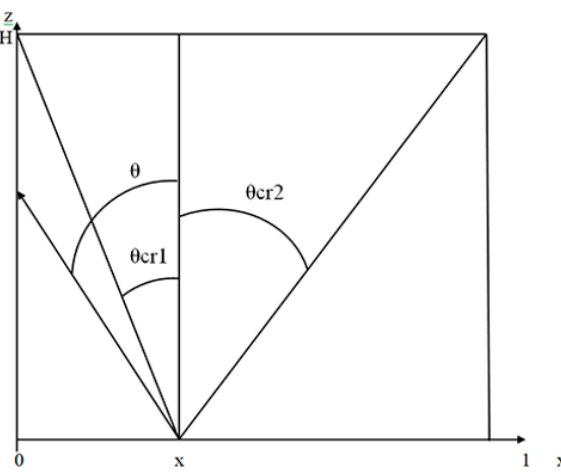
Fig. 4. Scheme of atom departure from the surface of the con- densed phase and hit the wall of the system.